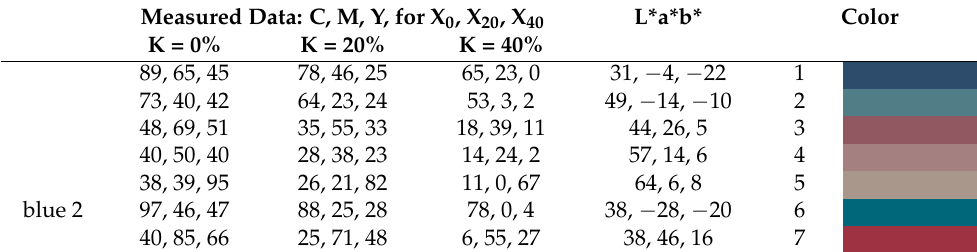
Table 1. Twelve twin dyes (inkjet plotter). Measured Data: C, M, Y, for X 0 , X 20 , X